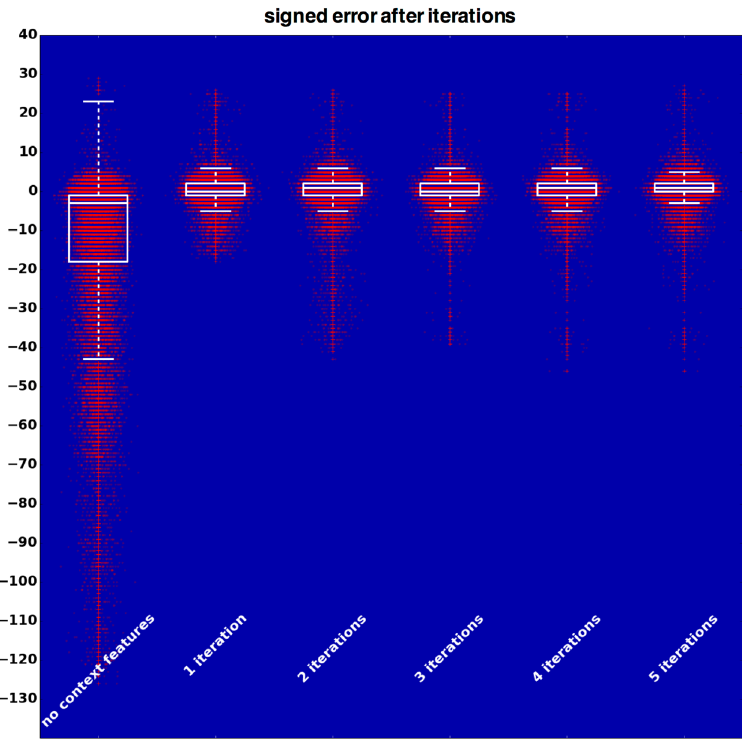
Figure 8. Increase in segmentation accuracy due to auto-context approach. Red dots indicate the signed error of each A-scan in the test set (with random horizontal displacement for visualization purposes), white markers show quartile and median error